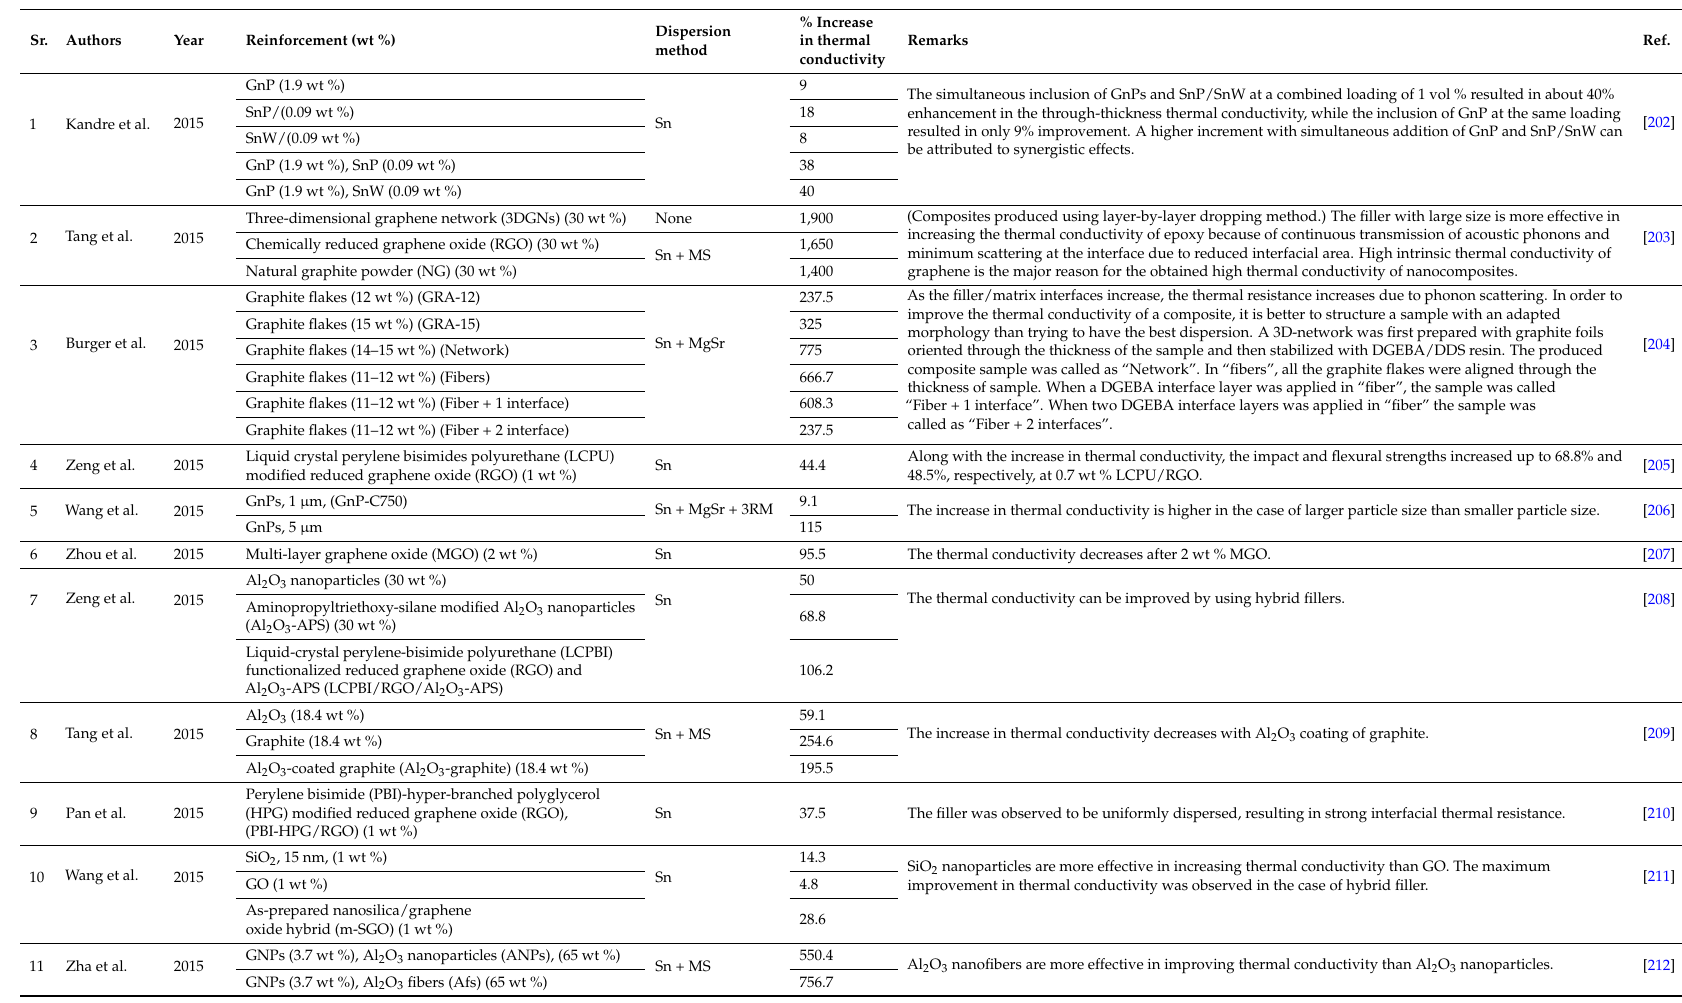
Table 2. A brief record of epoxy-based nanocomposites studied for improvement in thermal conductivity